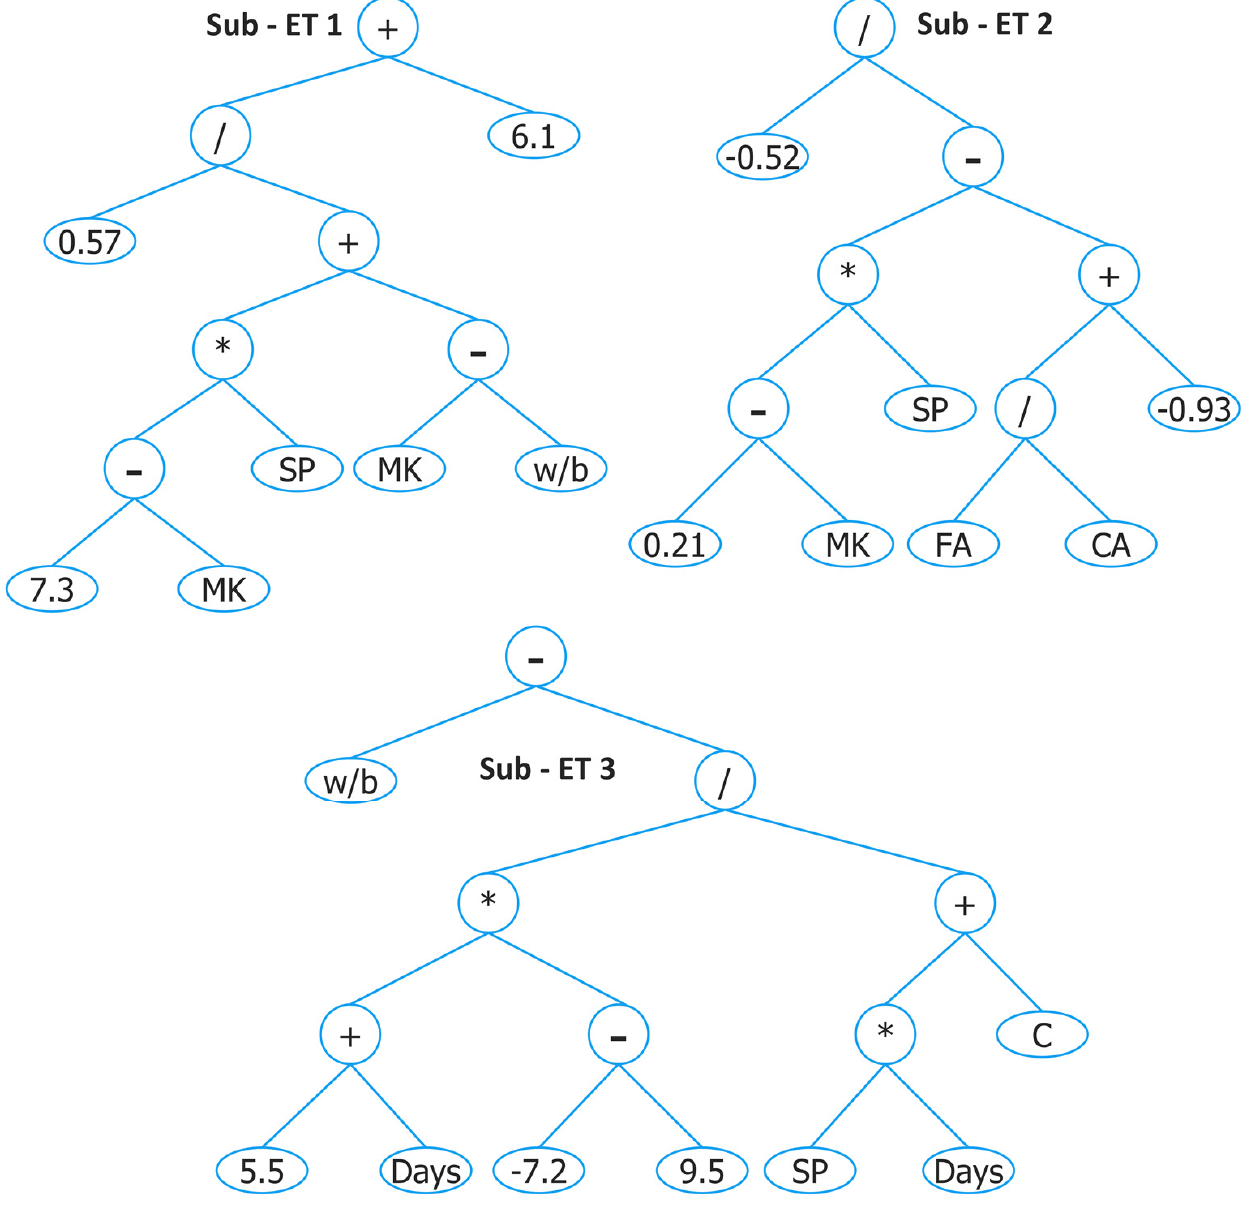
Figure 18. Expression tree developed by GEP III.